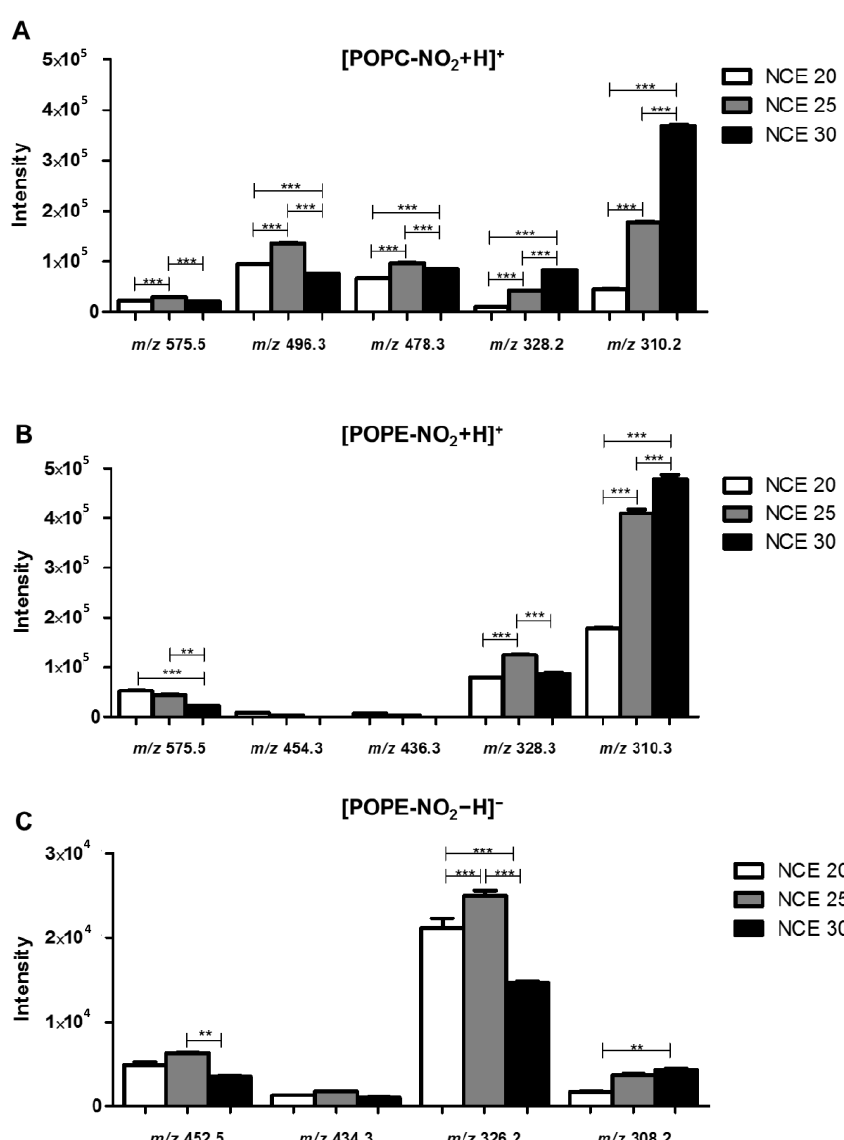
Figure 2. Effect of the low (20), medium (25) and the high (30) NCE in the intensity of the fragment ions with lower m / z values identified in the HCD-MS/MS spectra of: ( A ) NO 2 -POPC ((M + H) + ); (B) NO 2 -POPE ((M + H) + ); ( C ) NO 2 -POPE ((M − H) − ). The identification of the fragment ions is reported in Table 1. Fragment ions at m / z 575.5 are formed by the combined neutral loss of nitrous acid (HNO 2) with the polar heads of phosphocholine (neutral loss (NL) of 47 plus 183 Da) or phosphoethanolamine (NL of 47 plus 141 Da). The fragment ions at m / z 496.3 and 478.3 (A) and m / z 454.3 and m / z 436.3 ( B ) arise from the neutral loss of nitrated oleic acid (NO 2 -OA) as keto (NL of 309 Da), (NO 2 -OA-H 2 O) and acid derivatives (NL of 327 Da, NO 2 -OA), respectively. The fragment ions at m / z 328.2 and 310.2 ( A and B ) correspond to the (NO 2 -OA + H) + and (NO 2 -OA − H 2 O + H) + fragment ions, respectively. Fragment ions at m / z 452.3 and 434.3 ( C ) correspond to the neutral loss of nitrated oleic acid (NO 2 -OA) as keto and acid derivatives, respectively, and the fragment ions at m / z 326.3 and m / z 308.3 correspond to the (NO 2 -OA − H) − and (NO 2 -OA − H 2 O − H) − ions, respectively. All the results were obtained using a concentration of 2 µg mL −1 of the PL derivatives. Values are the means of three experiments ± standard deviation (SD). Statistical significance was determined using ANOVA and Tukey’s multiple comparison tests (± SD, ** p < 0.01, *** p < 0.001).